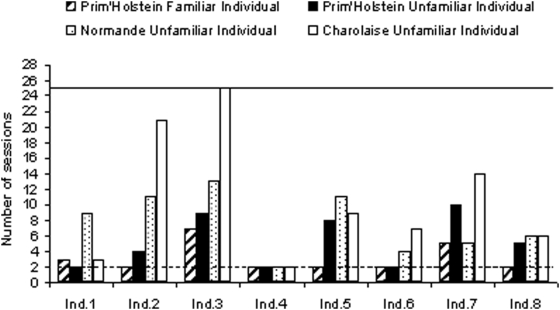
Performance of heifers during the generalization tests of the four experiments.Subjects recognized a familiar Prim'Holstein individual (experiment 1), an unfamiliar Prim'Holstein individual (experiment 2), an unfamiliar Normande individual (experiment 3) and an unfamiliar Charolaise individual (experiment 4). The minimum number of sessions to validate the criterion level (8/10 in two consecutive sessions) is indicated with a dotted line and the maximum number of sessions realized in an experiment (25 sessions) with a continuous line. One session corresponds to 10 consecutive trials. Along the x axis, subjects (Ind. 1 to Ind. 8) are sorted according to decreasing age (oldest to youngest).